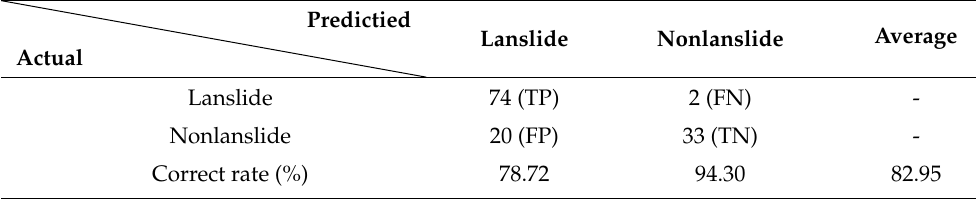
Table 4. Confusion matrix for the case of the Siaolin Village